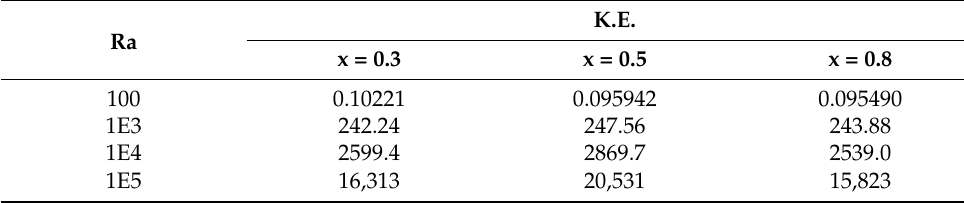
Table 6. Kinetic energy tabulation for varying Ra.